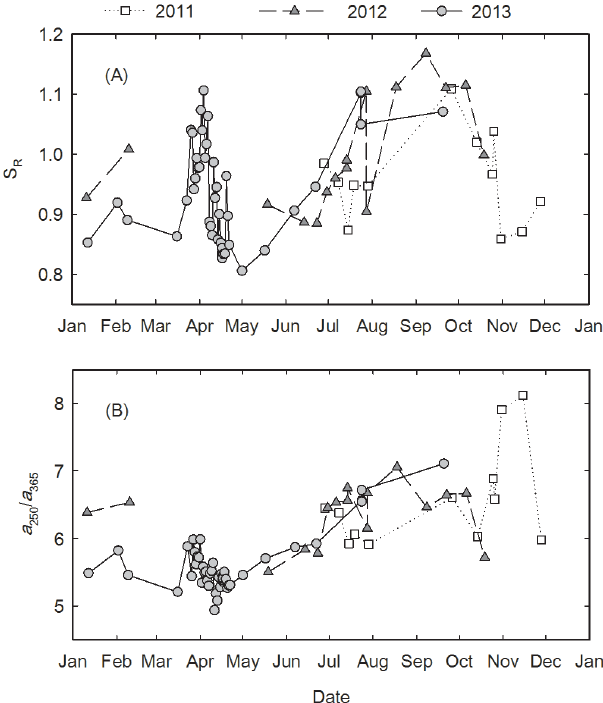
Figure 5. (a) Spectral slope ratio ( S R ) and (b) absorbance ratio ( a 250 /a 365 ) show rapid changes in DOM composition during the early freshet DOC pulse. A more gradual return to pre-freshet com- position follows throughout the summer. A second cycle occurs in late